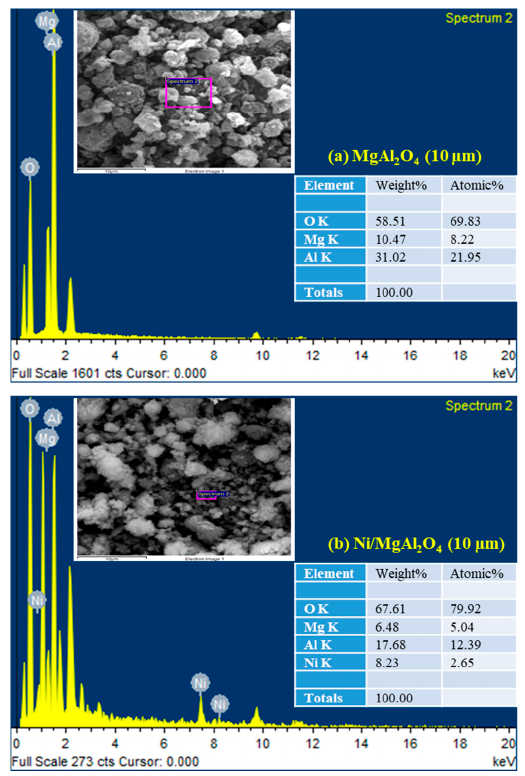
Figure5. ( a )EDXelementalanalysisof( a )MgAl 2 O 4 ( b )10wt%Ni / MgAl 2 O 4 Figure 5. ( a ) EDX elemental analysis of ( a ) MgAl 2 O 4 ( b ) 10 wt% Ni/MgAl 2 O 4 of using point ID technique.